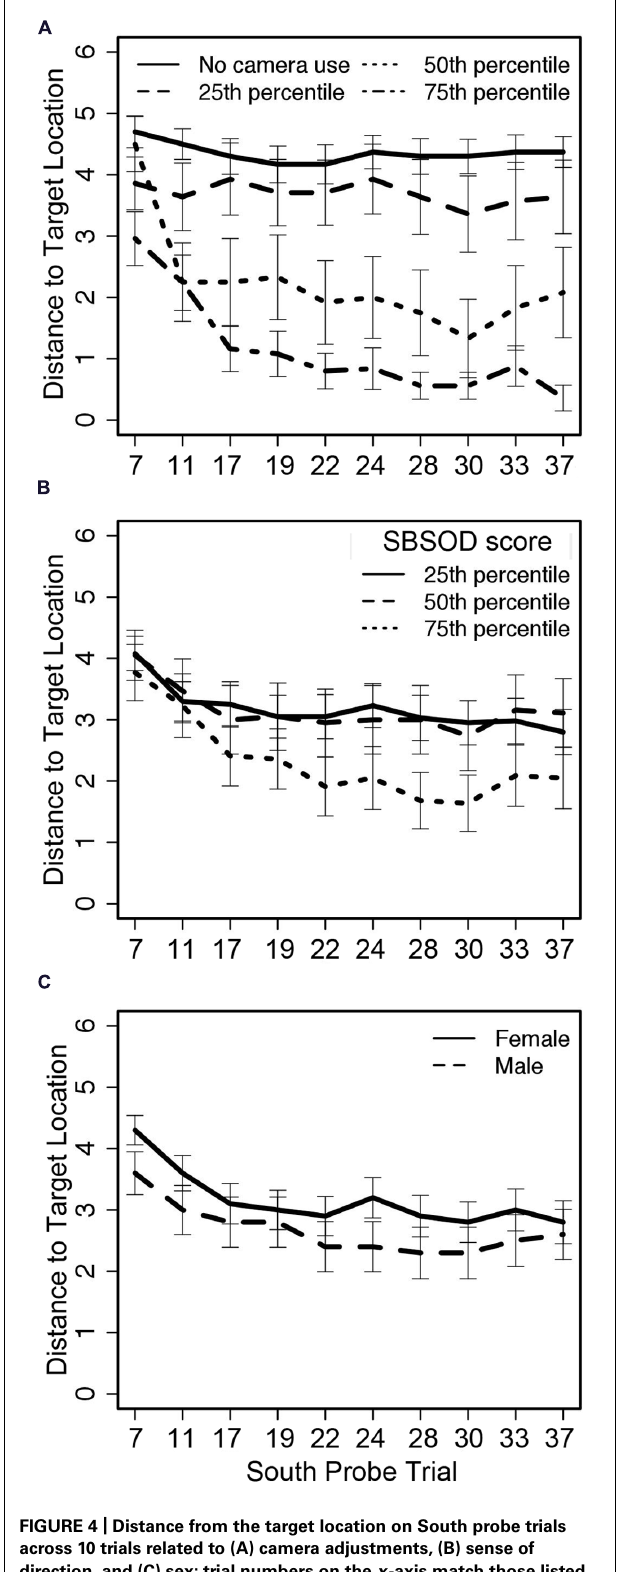
FIGURE 4 | Distance from the target location on South probe trials across 10 trials related to (A) camera adjustments, (B) sense of direction, and (C) sex; trial numbers on the x -axis match those listed inTable